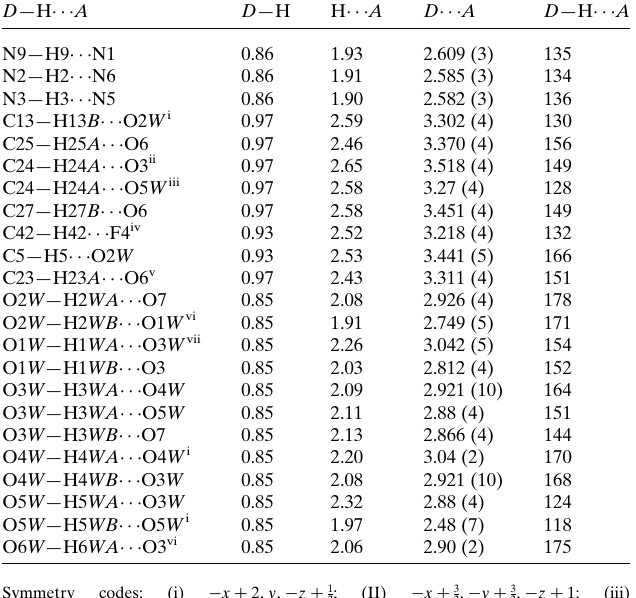
Table 1 Hydrogen-bond geometry (A˚ , (cid:4)